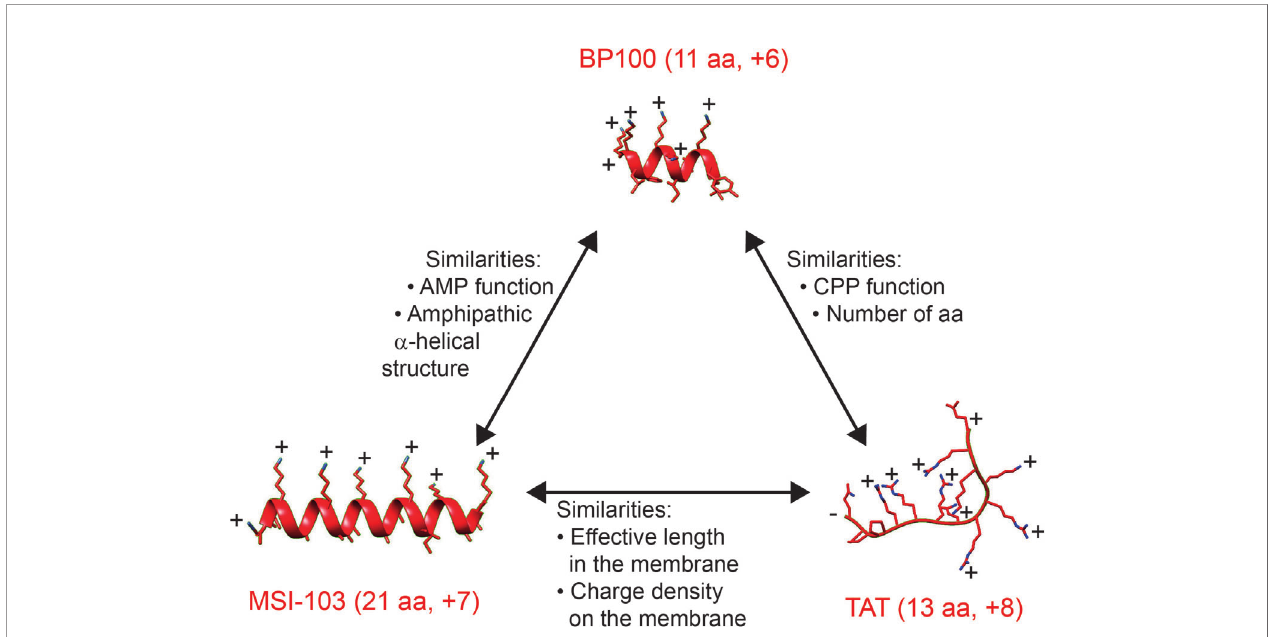
FIGURE 1 | Comparison of BP100, MSI-103, and TAT, all of which have a similar net charge. On the one hand, BP100 resembles MSI-103 in having a similar AMP function and amphipathic a -helical structure, and on the other hand, BP100 has a similar CPP function and short sequence as TAT. However, these two types of representative peptides – MSI-103 and TAT – differ fundamentally in size and secondary structure. We suggest that MSI-103 and TAT may nevertheless resemble each other in terms of their similar effective length and similar charge density, when considering their respective a -helical and unstructured forms in the membrane- bound state. Peptides are shown with helices as ribbons, side chains as stick models, with N atoms in blue. Side chain and terminal charges are indicated. TAT is unstructured and highly fl exible; only one of the possible and interchanging conformations is shown. [Helix fi gures were prepared using the 3D-HM web application (Reißer et al., 2014). The structure rendering was done using UCSF Chimera (Pettersen et al., 2004)].